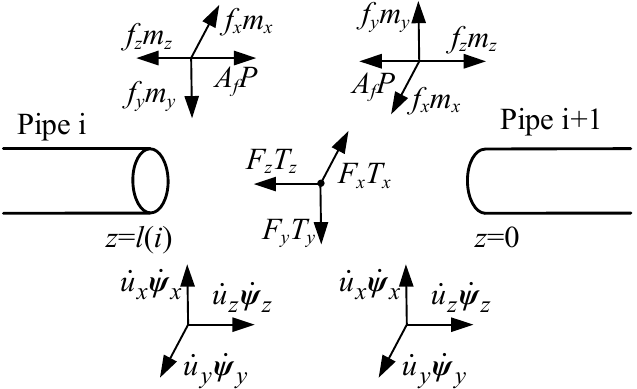
Figure 3. Local coordinate systems of middle node. Reprinted with permission from Ref. [24]. Cop- yright © 2013 Elsevier Ltd. All rights reserved.